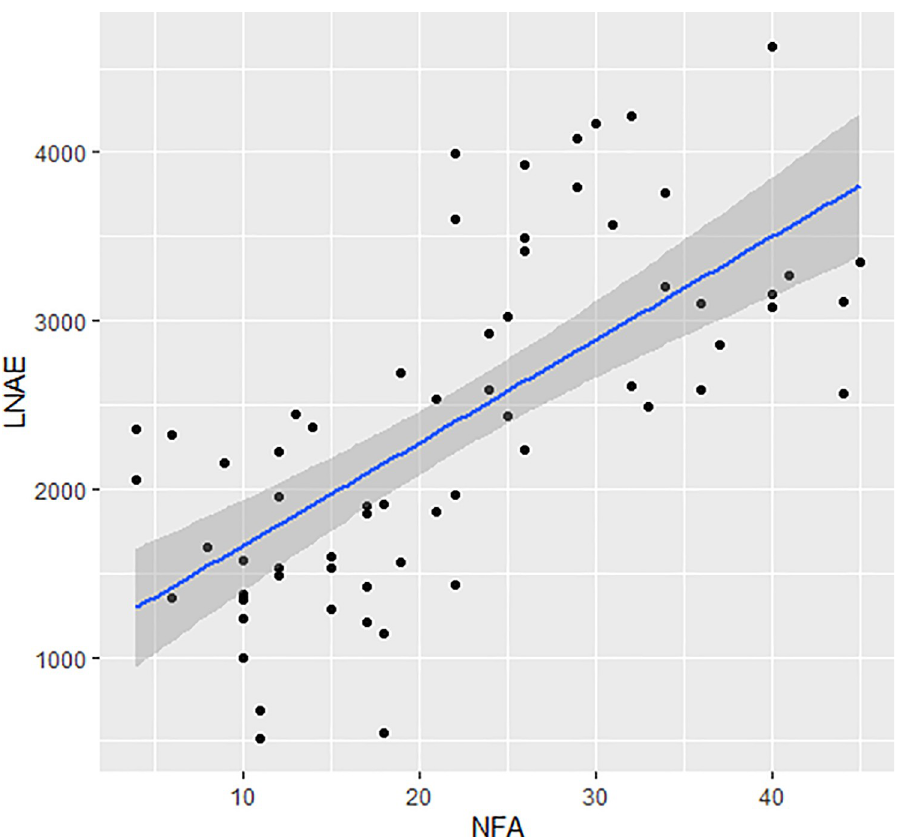
Fig 6. LNAE of 64 tropical maize lines as a function of the favorable alleles (NFA) in 29 SNPs with Fst > 0.2 between H_LNAE and L_LNAE groups.